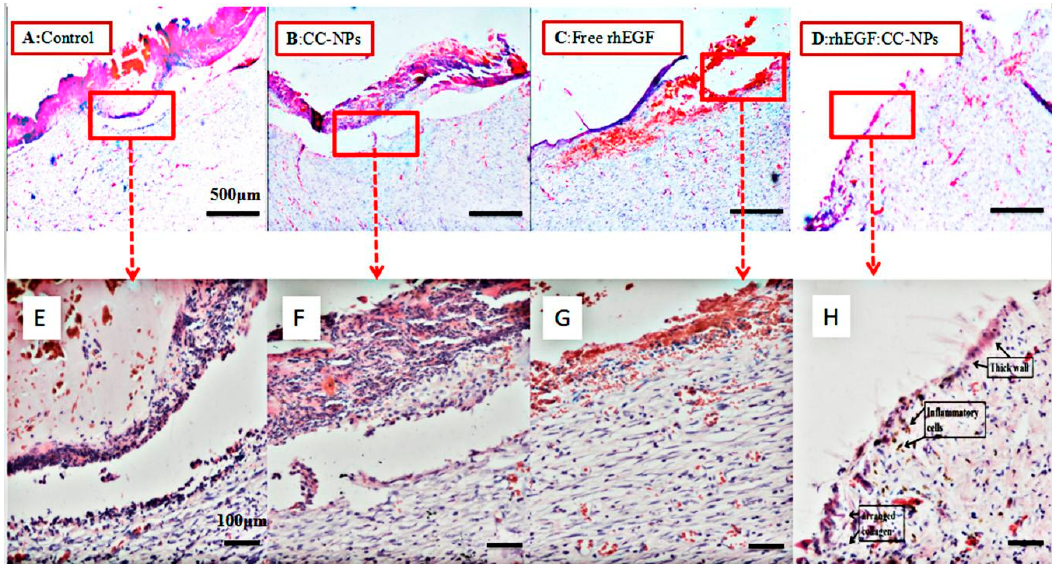
Figure 9. Hematoxylin and eosin (H&E) staining images of the wounds on the 14th day. ( A ) blank control group; ( B ) CC-NPs treatment group; ( C ) free rhEGF treatment group; ( D ) rhEGF:CC-NPs treatment group; ( E – H ) enlarged details of Figures A-D, respectively.